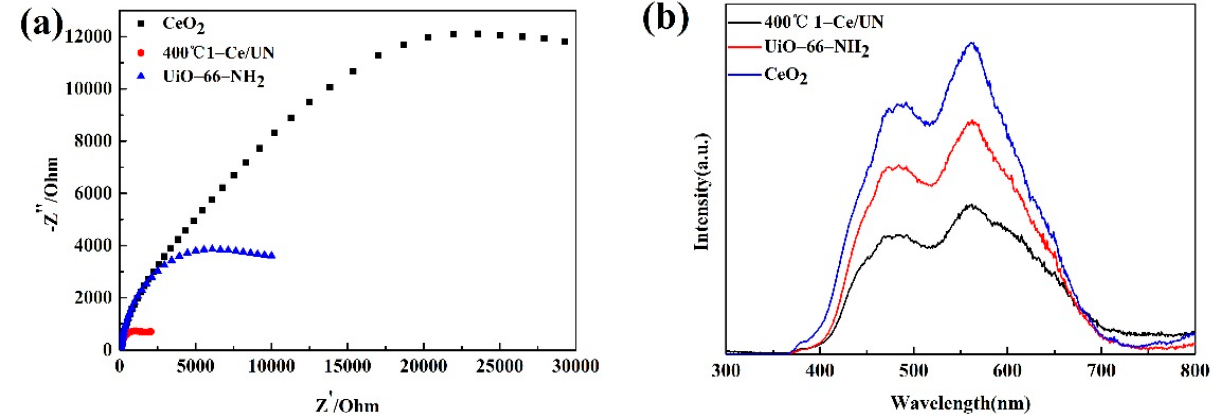
◦ C 1-Ce/UN ( a ) EIS Nyquist diagram and ( b ) PL Figure 14. CeO 2 , UiO-66-NH 2 and 400 °C 1-Ce/UN ( a ) EIS Nyquist diagram and ( b ) PL diagram. Figure 14. CeO 2 , UiO-66-NH 2 and 400